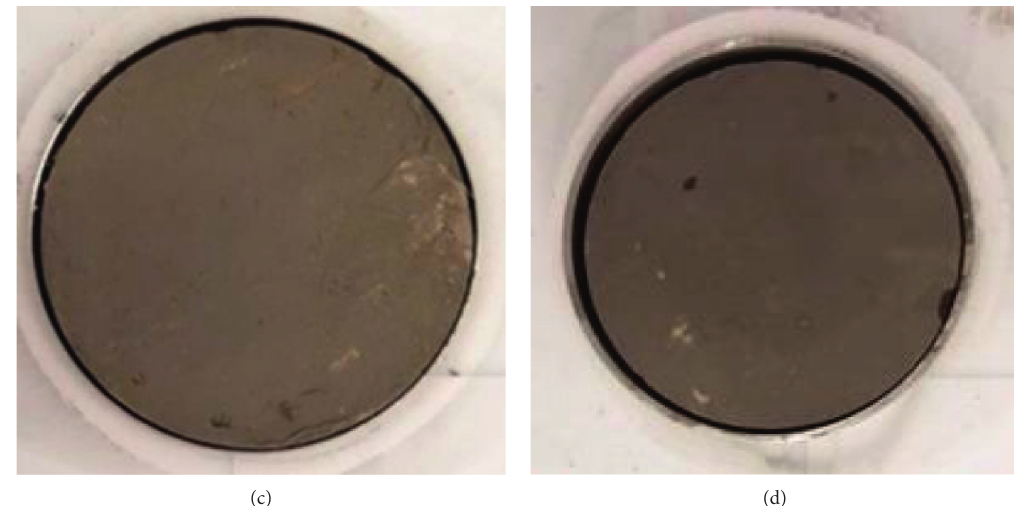
Figure 4: The changes in apparent characteristics of indoor soaked contaminated samples by TCE ( t � 212 days). (a) Layer (2). (b) Layer (3). (c) Layer (4). (d) Layer (5).